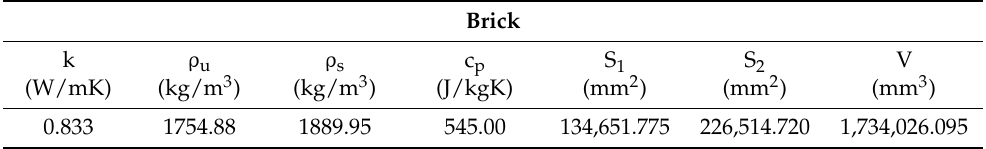
Table 5. Thermophysical and geometric parameters of the brick used in the